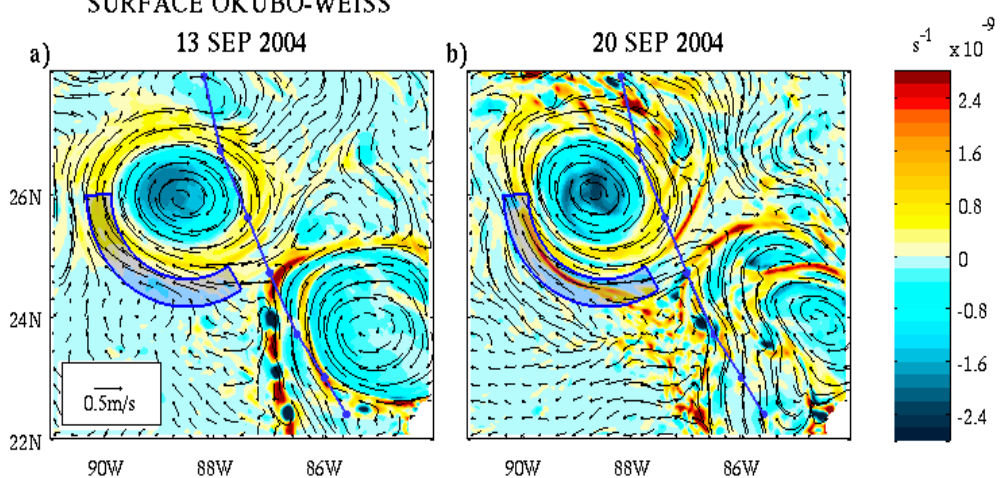
Figure 5. Okubo–Weiss parameter (shaded) for ( a ) 0000 UTC 13 September 2004 and ( b ) 0000 UTC 20 September 2004. Vectors represent surface currents’ strength and direction. Hurricane Ivan track is indicated by the dark purple line, with waypoints at each 0000 and 1200 UTC location. The blue shaded area represents the primary area of interest surrounding the filament.